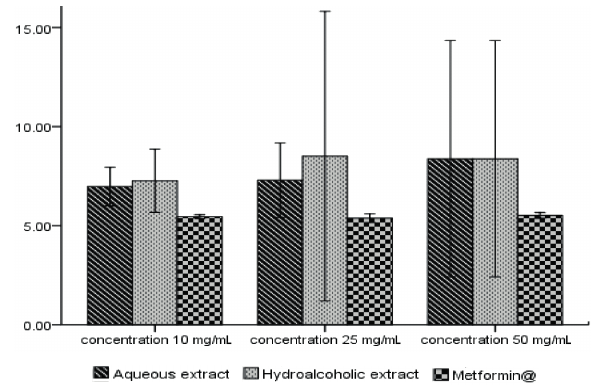
Figure 1 Inhibition of α-amylase, IC